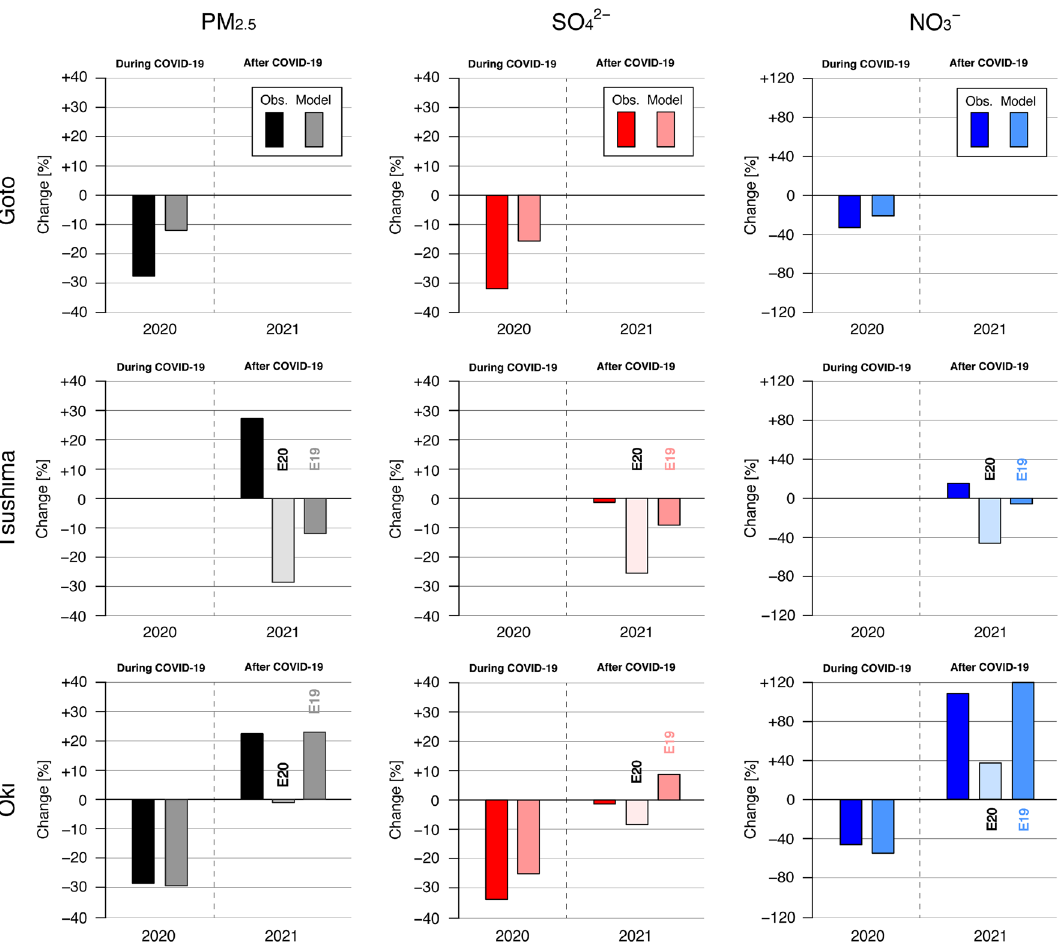
Figure 3. Changes in two-month (February and March) averaged (left) PM 2.5 , (centre) SO 4 2− and (right) NO 3 − concentrations during and after COVID-19 at (top) Goto, (middle) Tsushima and (bottom) Oki. These were calculated from the mean values in Fig. 2. For each year, the observation is shown on the left and the model is shown on the right. For 2021, the model experiments of M21E20 and M21E19 are shown by the lighter colour and darker colour and denoted as E20 and E19,